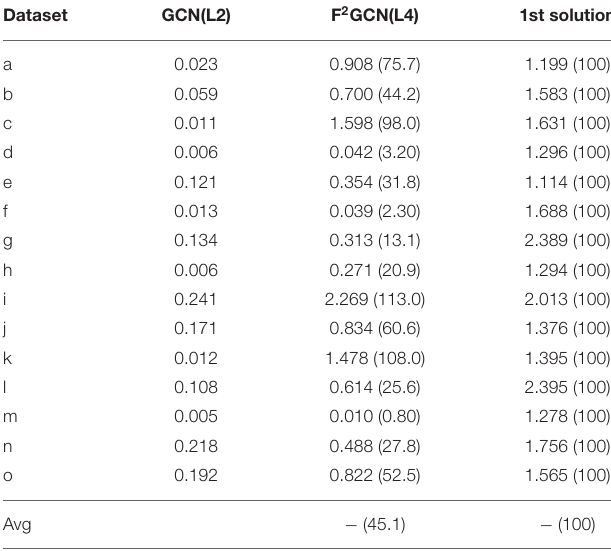
TABLE 5 | Number of parameters of baseline, 1st solution and F 2 GCN (Unit: Millions). Dataset